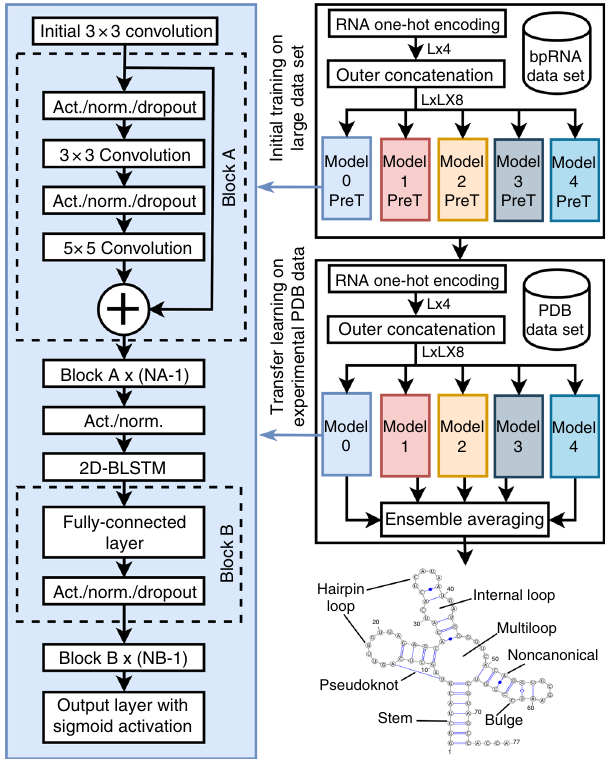
Fig. 1 Generalized model architecture of SPOT-RNA. The network layout of the SPOT-RNA, where L is the sequence length of a target RNA, Act. indicates the activation function, Norm. indicates the normalization function, and PreT indicates the pretrained (initial trained) models trained on the bpRNA